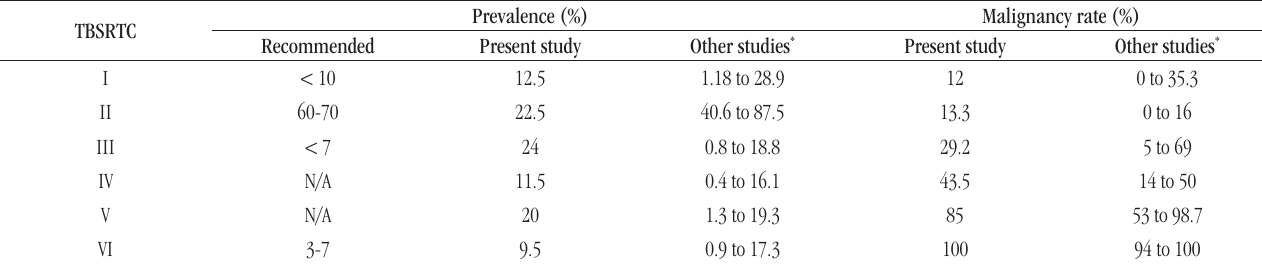
taBLE 3 − Comparison between the rates of malignancy and prevalences in each diagnostic category recommended